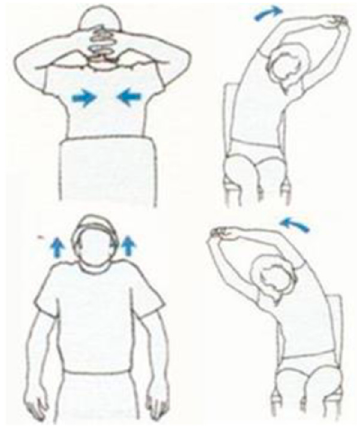
Figure 6. Four types of rehabilitation exercises.